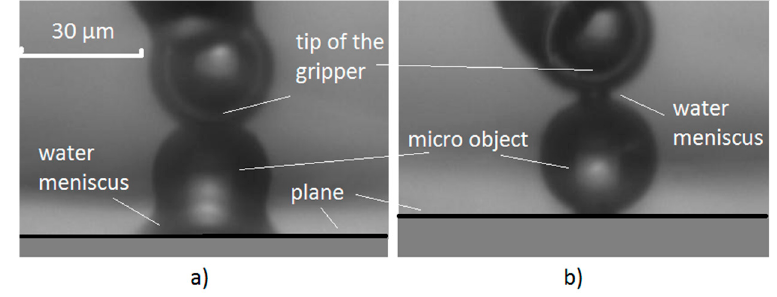
Figure 4. ( a ) Water meniscus is formed between the glass plane and a polystyrene micro-object with a radius of 30 µm; ( b ) water meniscus is formed between the tip of the gripper and a polystyrene micro-object.